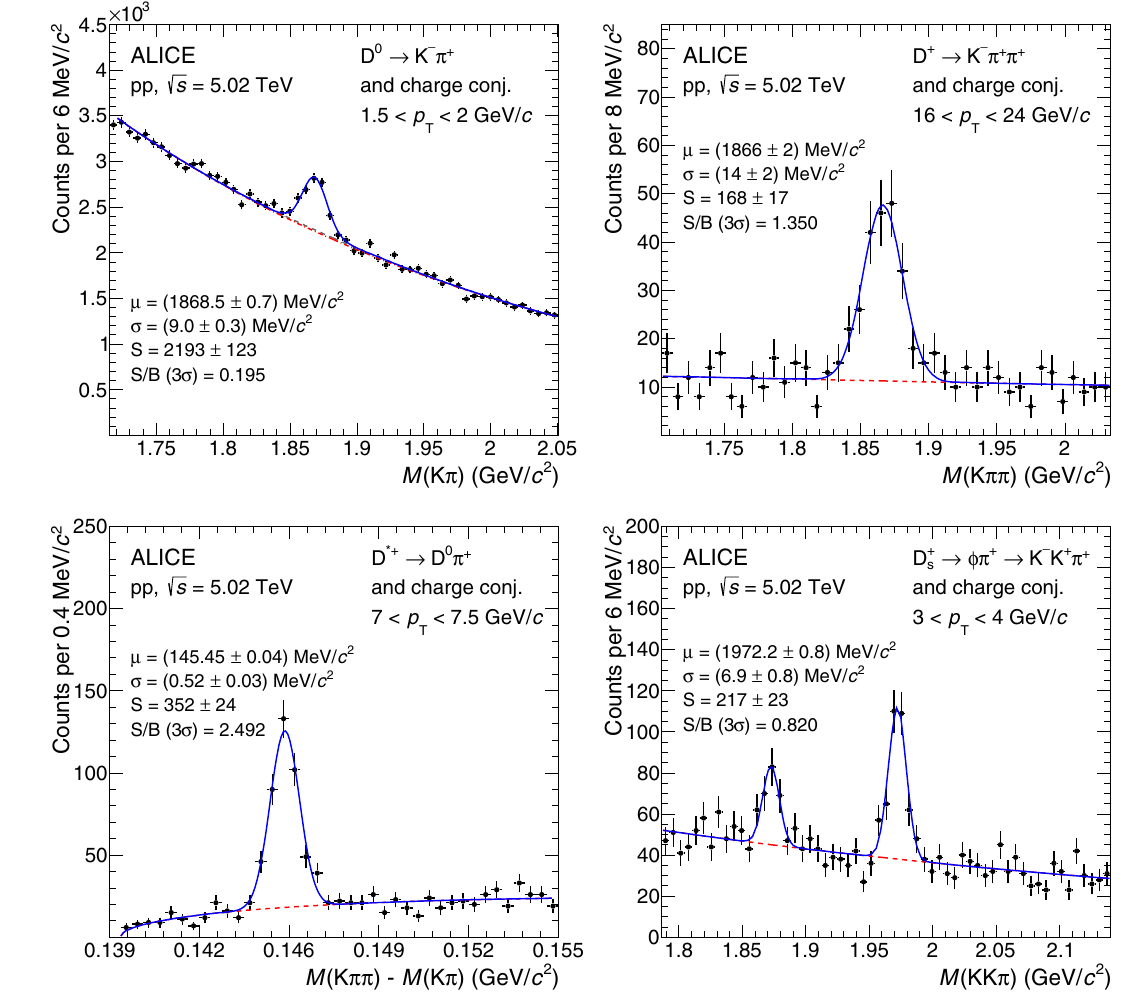
Fig. 1 Invariant-mass (mass-difference) distributions of D 0 , D + , D ∗+ , and D + s candidates and charge conjugates in 1 . 5 < p T < 2 GeV / c , 16 < p T < 24 GeV / c , 7 < p T < 7 . 5 GeV / c , and 3 < p T < 4 GeV / c intervals, respectively. The blue solid lines show the total fit functions as described in the text and the red dashed lines are the combinatorial- background terms. In case of D 0 , the grey dashed line represents the